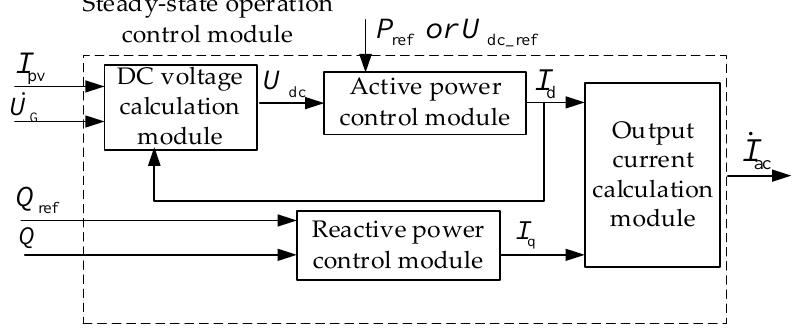
Figure 4. Inverter control and protection model.